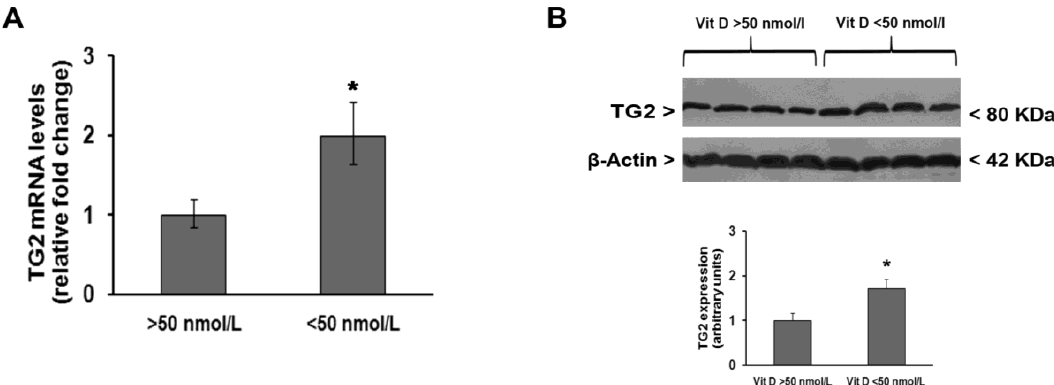
Figure 1. Changes in transglutaminase 2 (TG2) expression in peripheral blood mononuclear cells (PBMC) are influenced by vitamin D status of adult male individuals recruited for this study. ( A ) Quantitative Real-time PCR analysis of TG2 mRNA levels after normalization against β -actin mRNA levels; ( B ) representative immunoblot of TG2 protein levels and densitometric analysis of immunoreactive bands after normalization against β -actin levels. * p < 0.05, significant difference in comparison to individuals having normal vitamin D levels.